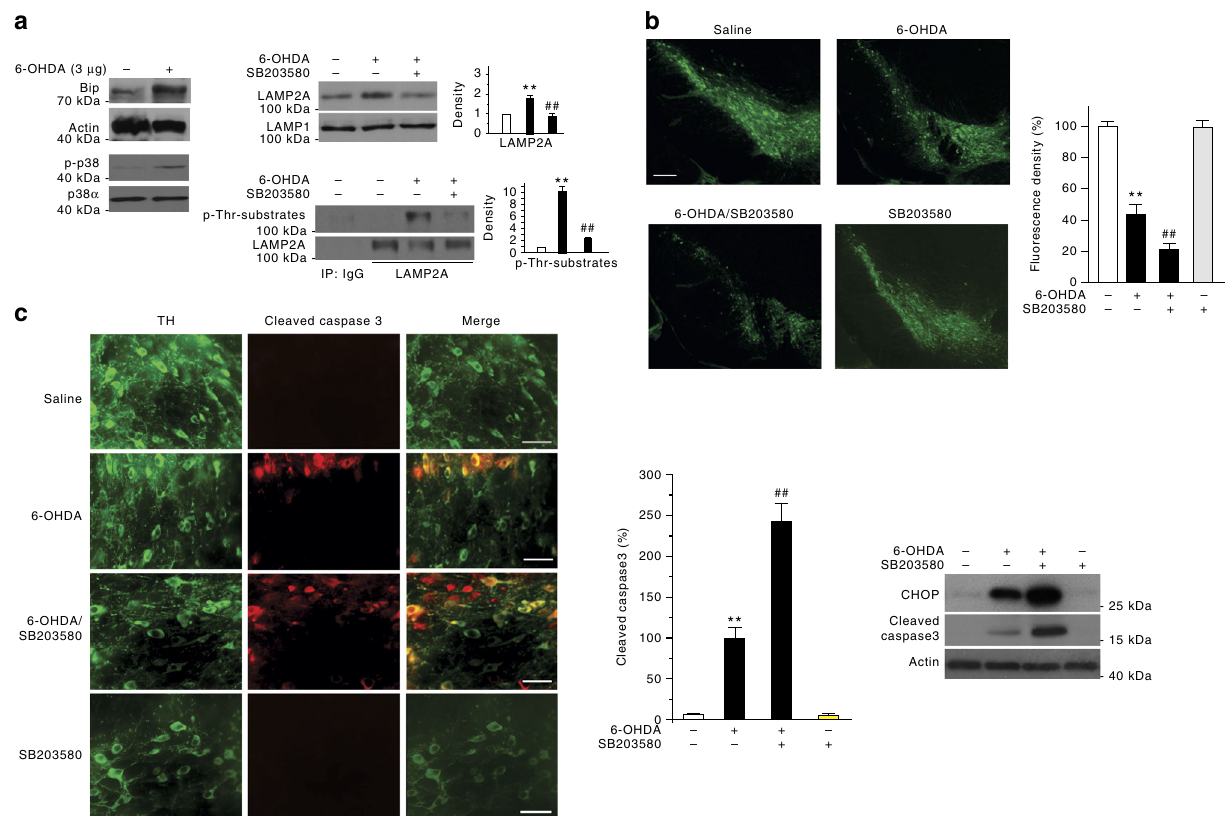
Fig. 9 Neurotoxin engages ER-p38 MAPK – CMA in mouse brain in a model of PD. a 6-OHDA treatment engages ER-p38 MAPK – CMA pathway in mouse brain. Mice were administrated with 6-OHDA (3 μ g) with or without co-injection of SB203580 (2 μ g) by unilateral stereotaxic injection to the SN region and killed after 2 days ( n = 16). Pooled SN tissues were analyzed for Bip, p-p38 α MAPK, and p38 α MAPK with the tissue lysate, and for LAMP2A and p- LAMP2A with the puri fi ed lysosomes. b Inhibition of p38 MAPK activity exacerbates 6-OHDA-induced loss of TH (tyrosine hydroxylase) positive neurons (green) in mouse SNc. Mice were stereotaxically injected with saline, 6-OHDA, 6-OHDA plus SB203580, and SB203580 at dosages as described in a . Mouse brain SNc slices were immunostained for TH (scale bar = 200 µ m). Right panel shows the quanti fi cation of TH positive neurons in each group. c Inhibition of p38 MAPK exacerbates 6-OHDA-induced activation of caspase 3. The SNc slices from mice treated as described in b were immunostained for TH (green) and activated caspase 3 (red) (scale bar = 25 µ m). Middle panel shows the quanti fi cation, and right panel shows the level of CHOP and cleaved caspase 3 by western blot. Quanti fi cations are shown for a , b , and c ( n = 6 per group. All values are mean ± s.d. (ANOVA with Turkey test. ** p < 0.005 vs. control and ## p < 0.005 vs.